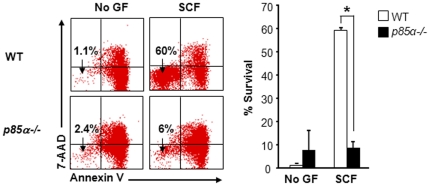
Defective survival of p85α-deficient BMMCs.BMMCs from WT and p85α−/− mice were starved for 6 hours in serum- and cytokine-free media and cultured in the presence or absence of SCF (50 ng/mL). After 48 hours, cells were stained with phycoerythrin-conjugated annexin V and 7-AAD followed by flow cytometry analysis. Shown is a representative dot blot (Left panel) and bar graph (Right panel) demonstrating percentage of annexin V and 7-AAD negative cells in the presence and absence of SCF. Similar results were observed in three independent experiments. *p<0.05, WT vs. p85α−/−.